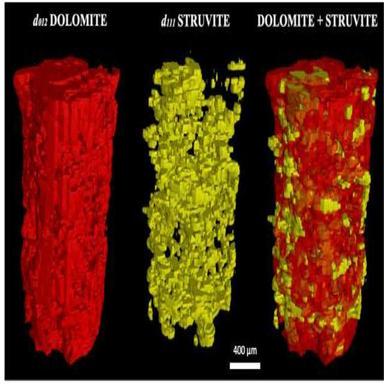
3D spatial distribution extracted from XRDCT results of dolomite and struvite in the DAP-treated Angera stone obtained by plotting the red channel of the RGB images. In the volume rendering on the right, the orange colour shows the overlapping regions of dolomite and struvite.(For interpretation of the references to color in this figure legend, the reader is referred to the web version of this article.)